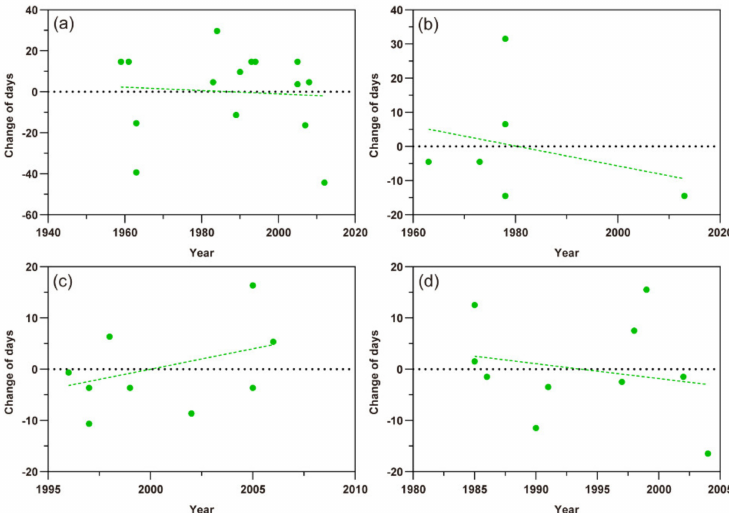
Figure 5. Scatter plots of the first occurrence dates of three aphid pests. The dots represent di ff erent records and the dashed lines show the trends of the first occurrence. ( a ) Myzus persicae ; ( b ) Sitobion avenae ; ( c ) Aphis gossypii in northern Xinjiang; ( d ) A. gossypii in southern